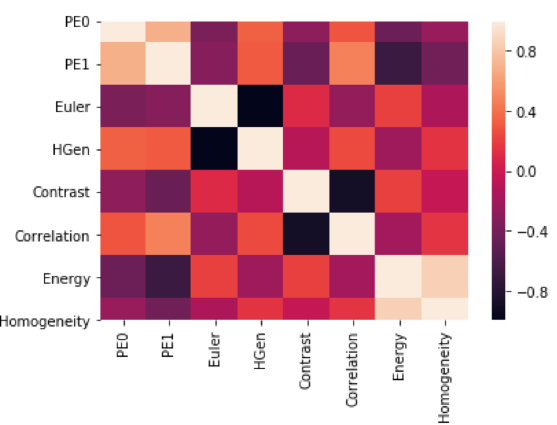
Figure 8. Heat map depicting the correlations among